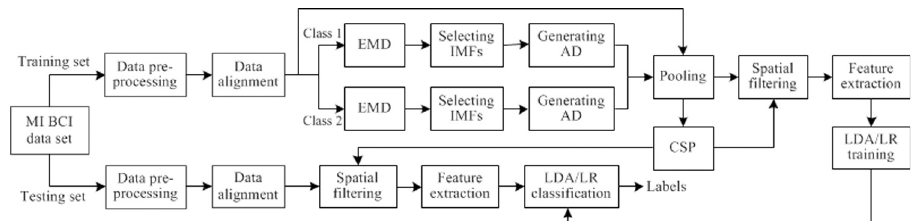
Fig 1. Algorithmic flowchart for classifying MI-based EEG signals using the proposed data augmentation algorithm based on CSP and LDA or LR. AD denotes artificial data.